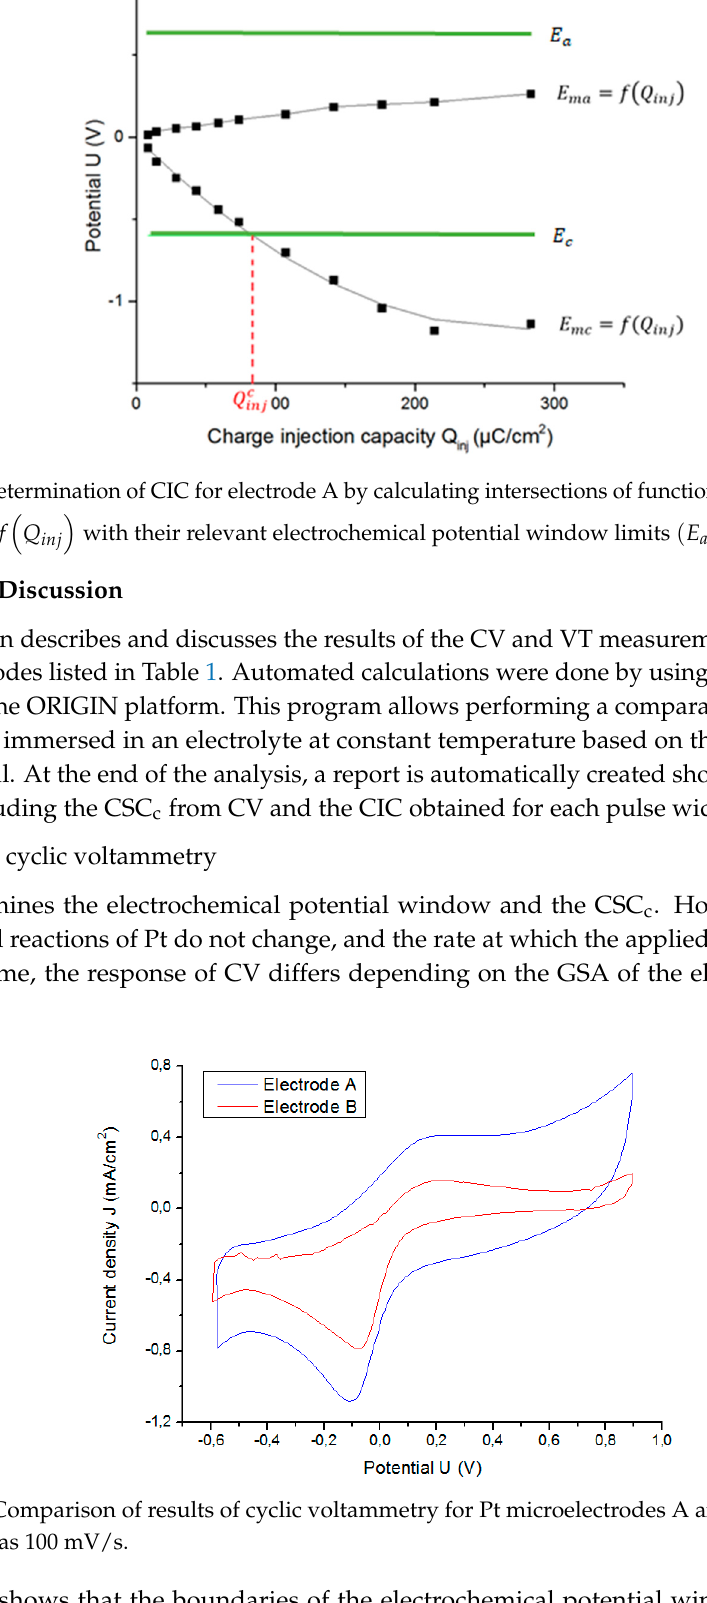
(cid:16) (cid:17) Q inj